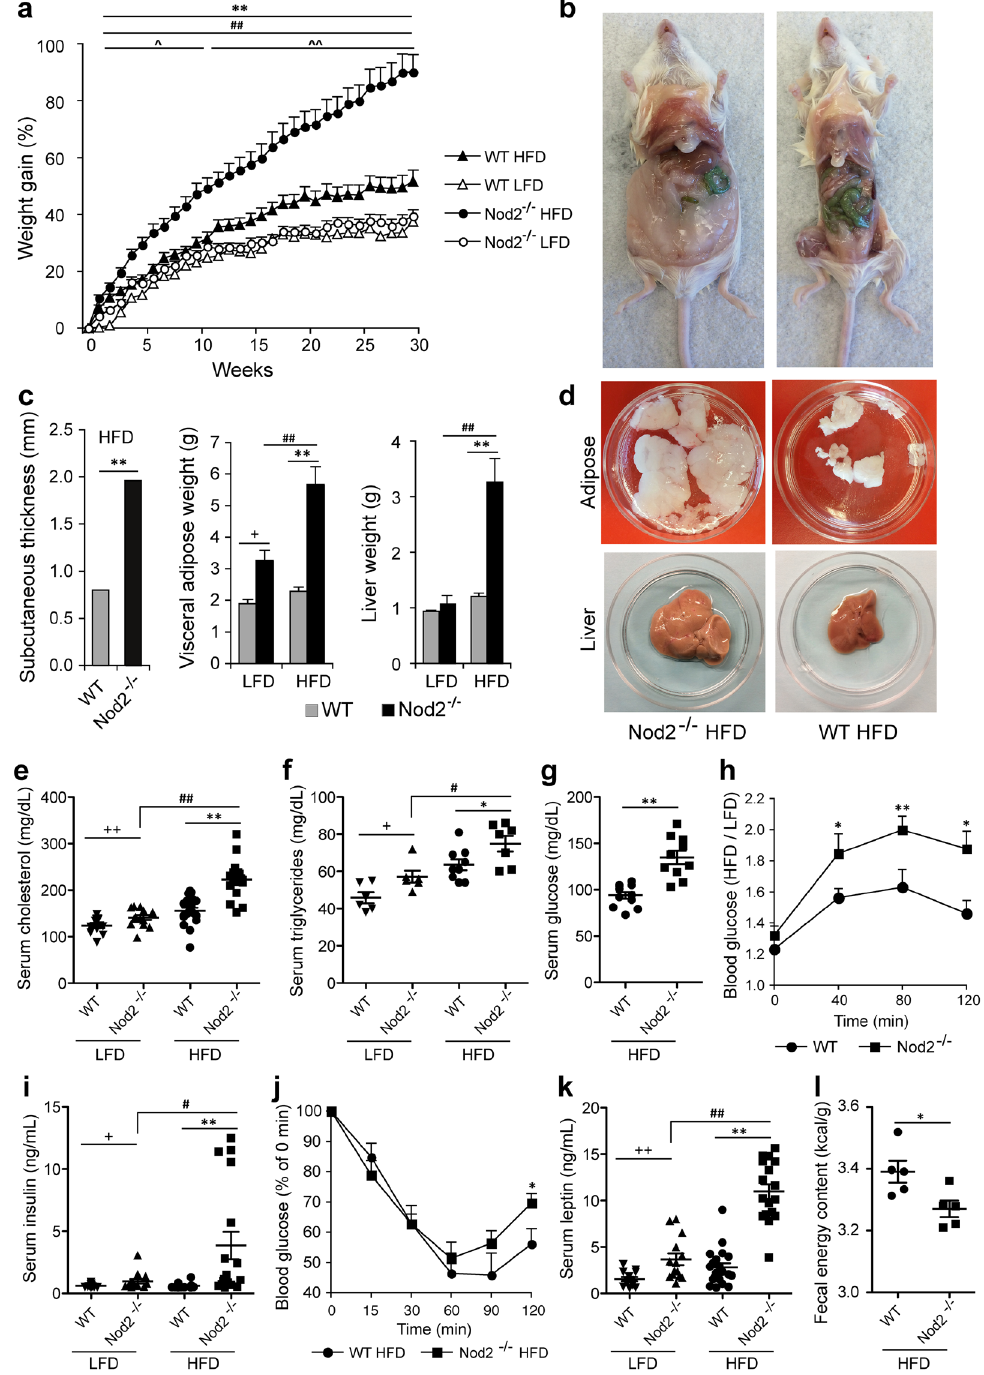
Figure 1. Nod2 − / − mice on HFD become obese and develop hyperlipidemia, hyperglycemia, and glucose intolerance. WT and Nod2 − / − mice were monitored for weight gain, increased adiposity, and assayed for metabolites. ( a ) Percent gain in body weight over week 0. ( b – d ) At week 30, ( b ) representative mice are shown for increase in overall size and visceral adipose tissue, ( c ) average increase in subcutaneous thickness and weight of visceral adipose tissue and liver per mouse, and ( d ) total visceral adipose tissue and liver from representative mice. ( e – j ) At week 30, mice were assayed for serum ( e ) cholesterol, ( f ) triglycerides, ( g ) glucose, ( i ) insulin, and ( k ) leptin, and for the development of ( h ) glucose tolerance and ( j ) insulin resistance. ( l ) Total caloric value in fecal samples. The results are ( a ) means ± SEM of 18–25 mice/group; ( c , h , j ) means ± SEM of 10–12 mice/group; or ( e – g , i , k , l ) for individual mice/group ± SEM. ( h ) Data for the glucose tolerance test is shown as ratio of HFD to LFD for each strain. * P ≤ 0.05, ** P ≤ 0.001, Nod2 − / − HFD versus WT HFD; # P ≤ 0.05, ## P ≤ 0.001, Nod2 − / − HFD versus Nod2 − / − LFD; ^ P ≤ 0.05, ^^ P ≤ 0.001, WT HFD versus WT LFD; + P ≤ 0.05, ++ P ≤ 0.001, Nod2 − / − LFD versus WT LFD. The results for food consumed and voluntary wheel activity are shown in Fig.